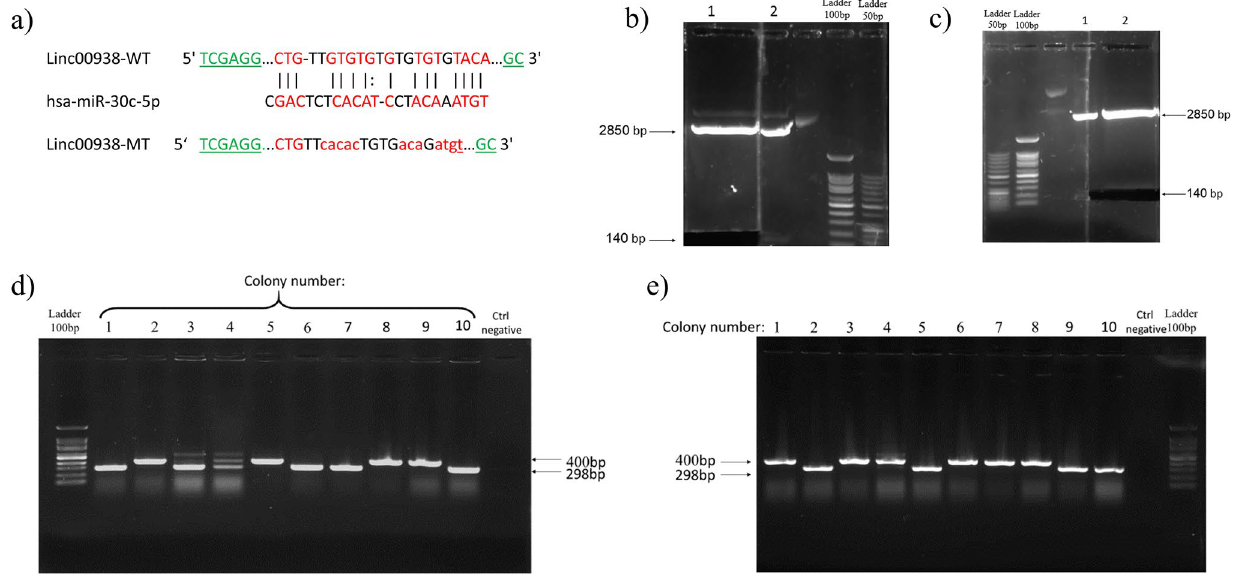
Figure 5. Linc00938 lncRNA regulated LRRK2 expression by directly sponging hsa-miR-30c-5p. ( a ) The predicted binding site between Linc00938 and hsa-miR-30c-5p, and the sequences of wild and mutant types of Linc00938 lncRNA; restriction sites have been underlined. The recombinant plasmids containing mutant and wild-type of linc00938 were termed as “MT” and “WT”, respectively. ( b , c ) Gel extraction of purchased Linc00938, which was double digested from the PUC57 vector by agarose gel electrophoresis for: ( b ) Linc00938 mutant, lane 1: fragments of the digested vector, lane2: detector for gel extraction, and ( c ) Linc00938 wild type, lane 1: detector for gel extraction and lane2: fragments of the digested vector. ( d , e ) The results of the colony- PCR for psiCHECK-2 recombinant by agarose gel electrophoresis, ( d ) the 2,5,8,9 colonies were the positive colony PCR of the linc00938 mutant, and ( e ) the 1,3,4,6,7,8 colonies were the positive colony PCR of linc00938 wild type. The high resolution figures of the electrophoretic gels are provided as Supplementary Fig.